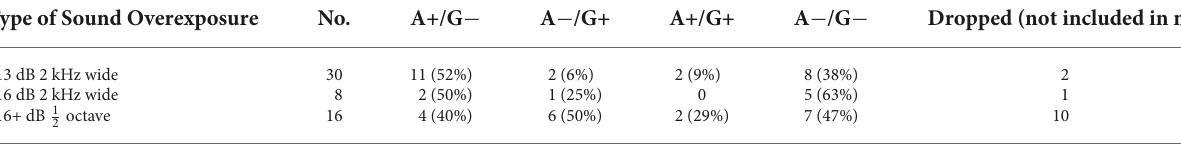
TABLE 1 Different sound overexposures have different distributions of tinnitus behavior. Type of Sound